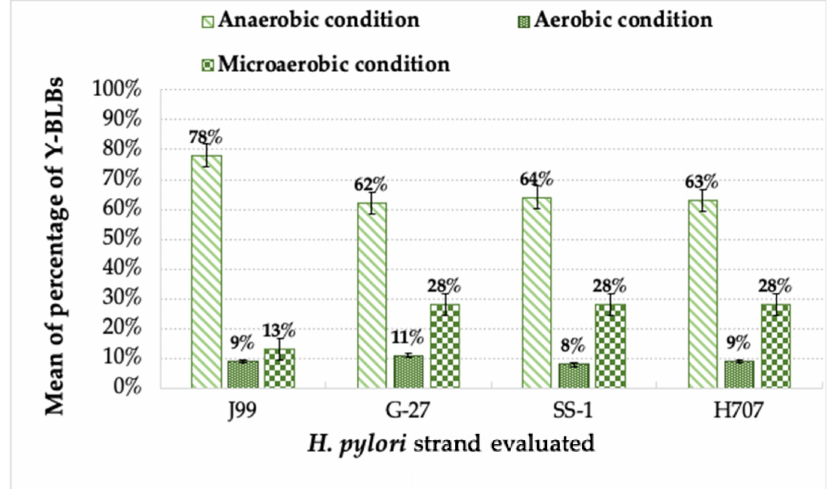
Figure 5. Means of the percentages of yeast cells harboring bacteria-like bodies (Y-BLBs) in co-cultures of H. pylori strains plus Candida strains incubated for 48 h under anaerobic, microaerobic, or aerobic conditions. The higher means of Y-BLB percentages were found in co-cultures including the H. pylori J99 strain incubated under anaerobic